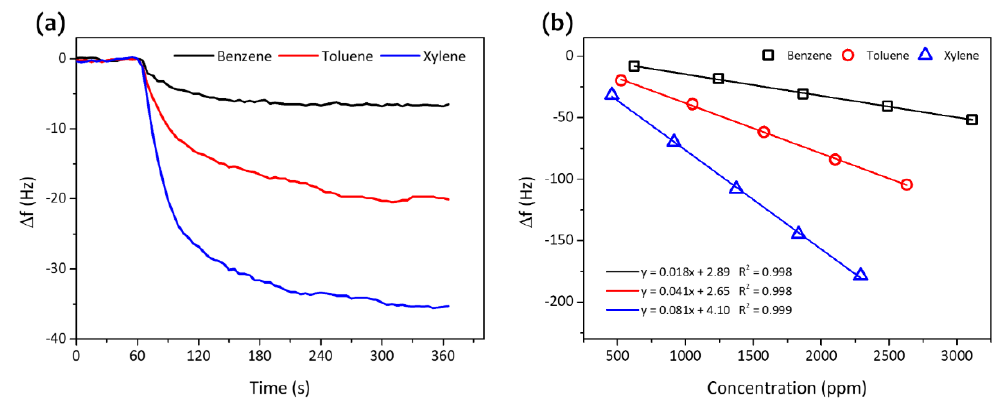
Figure 4. ( a ) Frequency shift of PVAc-based QCM sensor after exposure to BTX analytes of 622 ppm, and ( b ) collated frequency shift after exposure to BTX with di ff erent concentrations for benzene of 622, 1244, 1866, 2488, and 3110 ppm, for toluene of 526, 1052, 1578, 2104, and 2630 ppm, and for xylene of 458, 916, 1374, 1832, and 2290 ppm.